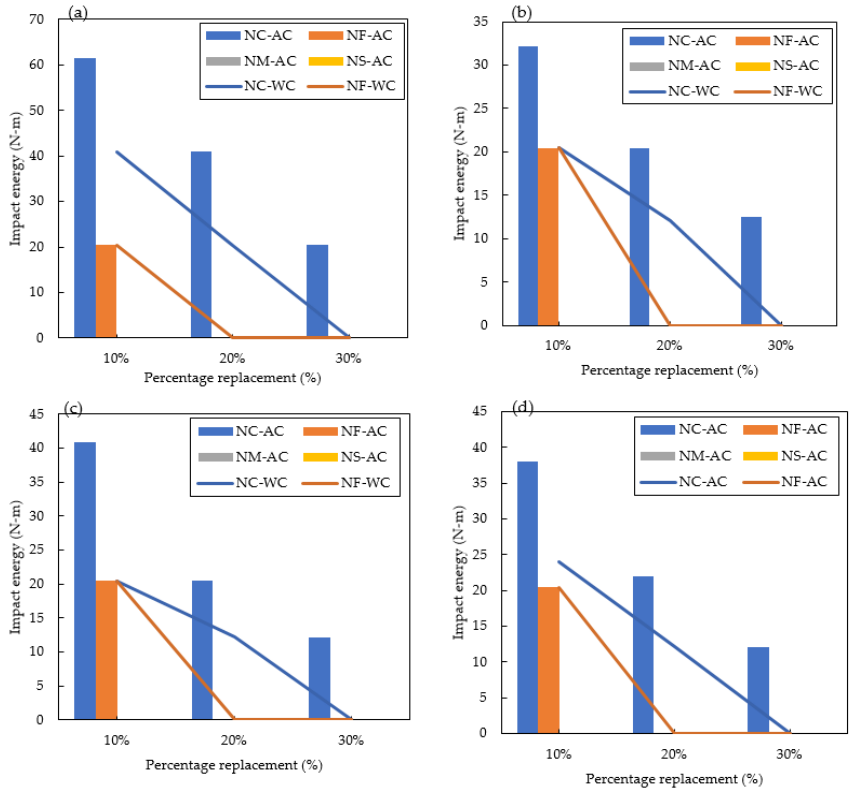
Figure 10. Impact energy versus percentages of nanomaterials in various grades at 1000 ◦ C: ( a ) M20; ( b ) M30; ( c ) M40; ( d ) M50.